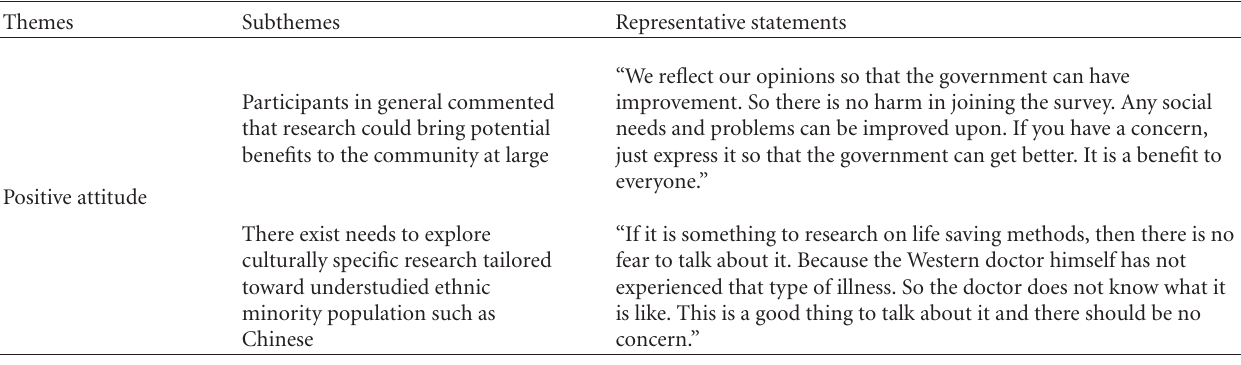
Table 3: Community’s Perception on Health Sciences